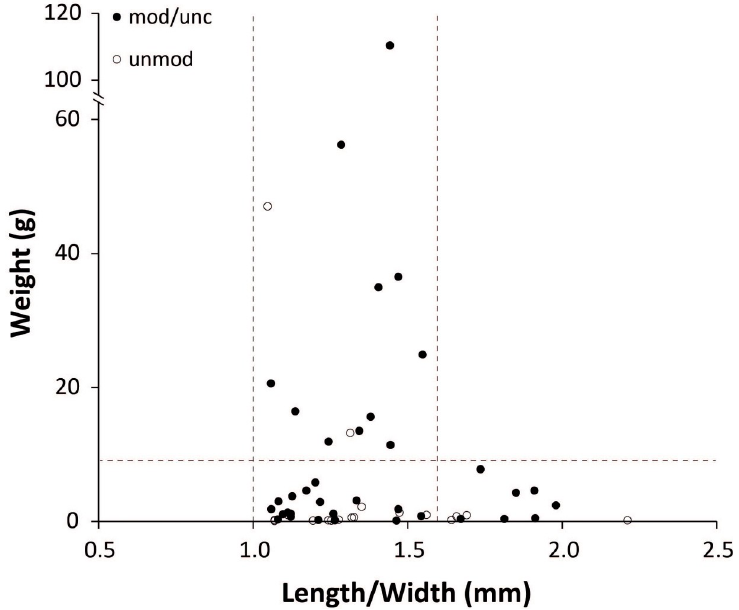
Fig 5. Weight vs. length/width ratio for manganese-rich rocks. Comparison between lump weight and length/width ratio. Dotted lines identify groups discussed in the text; mod/unc—modified/possibly modified; unmod—unmodified.